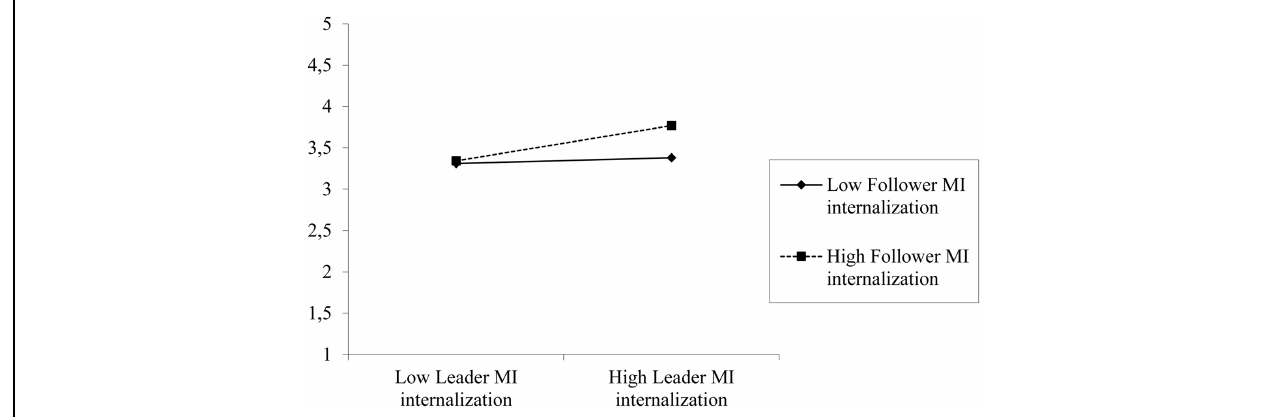
FIGURE 2 | Interactive effects of follower and leader MI (moral identity) internalization on ethical leadership perceptions based on Analysis 1 reported in Table